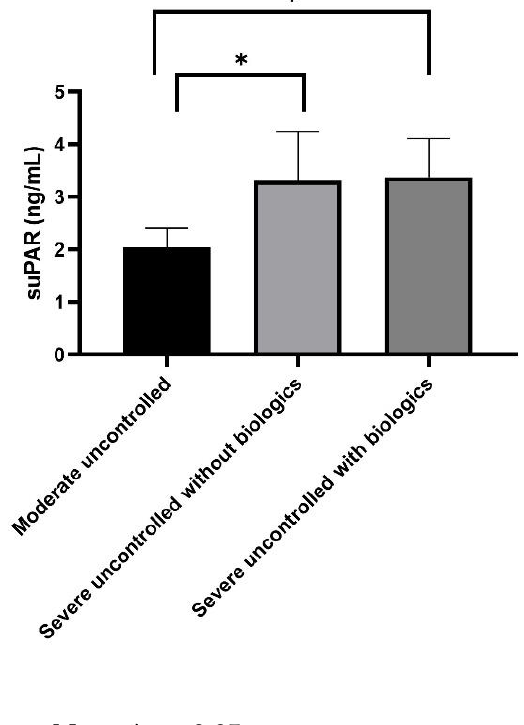
Figure 2. Comparison of serum ssoluble urokinase plasminogen activator receptor (suPAR) levels between moderate uncontrolled and severe uncontrolled asthmatics. Note: * p < 0.05 No correlations were found between suPAR levels and age, BMI, T2 biomarkers, white blood cell count, CRP, electrolytes, parameters of the kidney and liver function, or spirometric parameters (Supplementary Table S1). The correlation analysis between su- PAR levels and the most important parameters is shown in Figure 3.